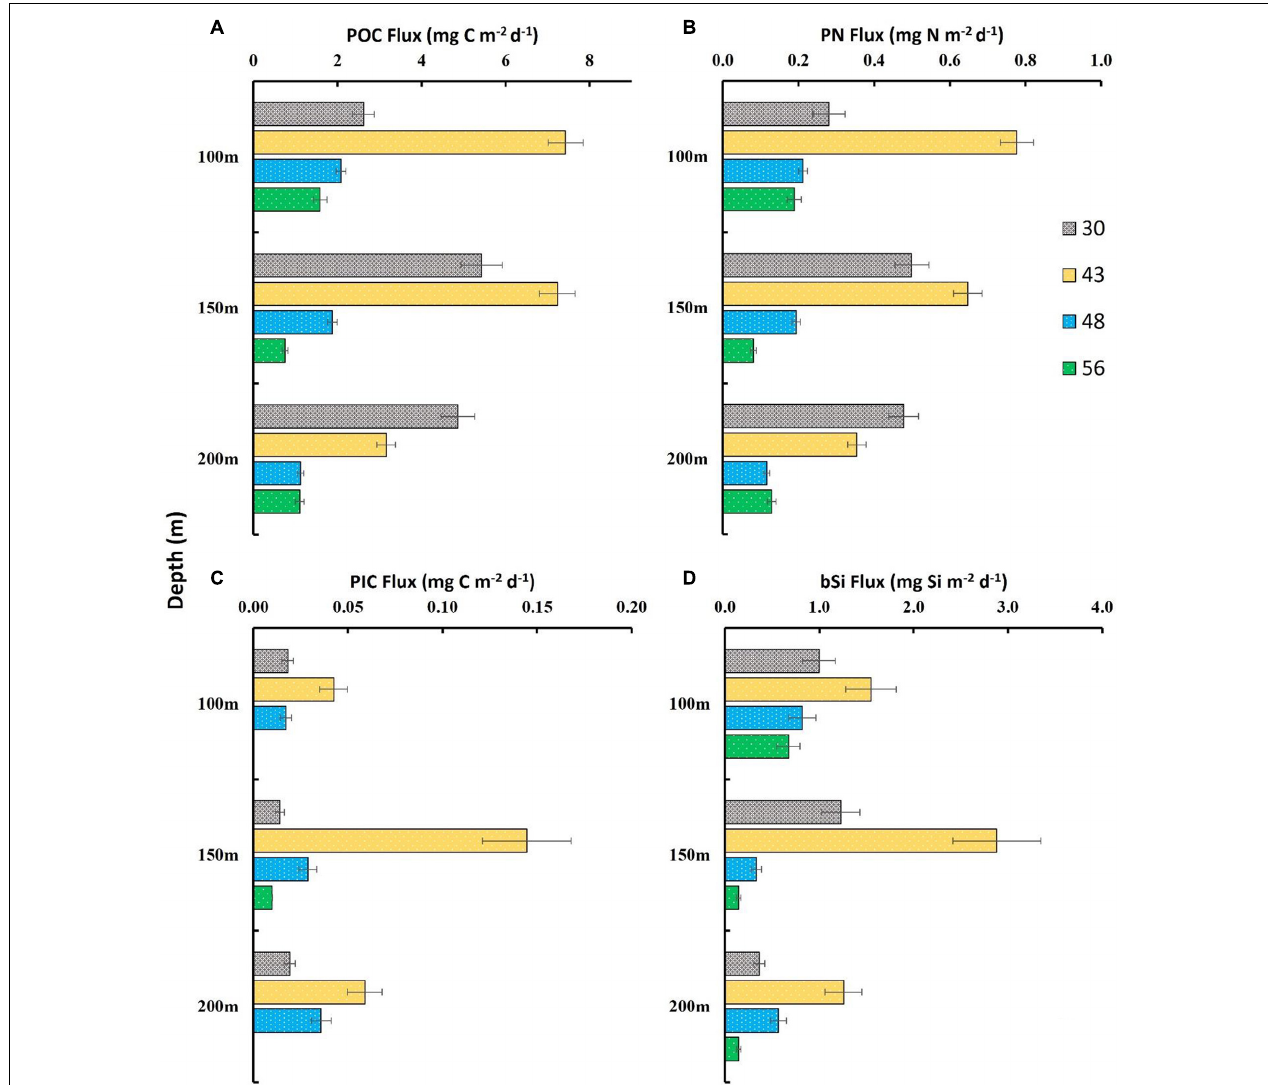
FIGURE 8 | Export fluxes of (A) POC, (B) PIC, (C) PN, and (D) bSi in the water